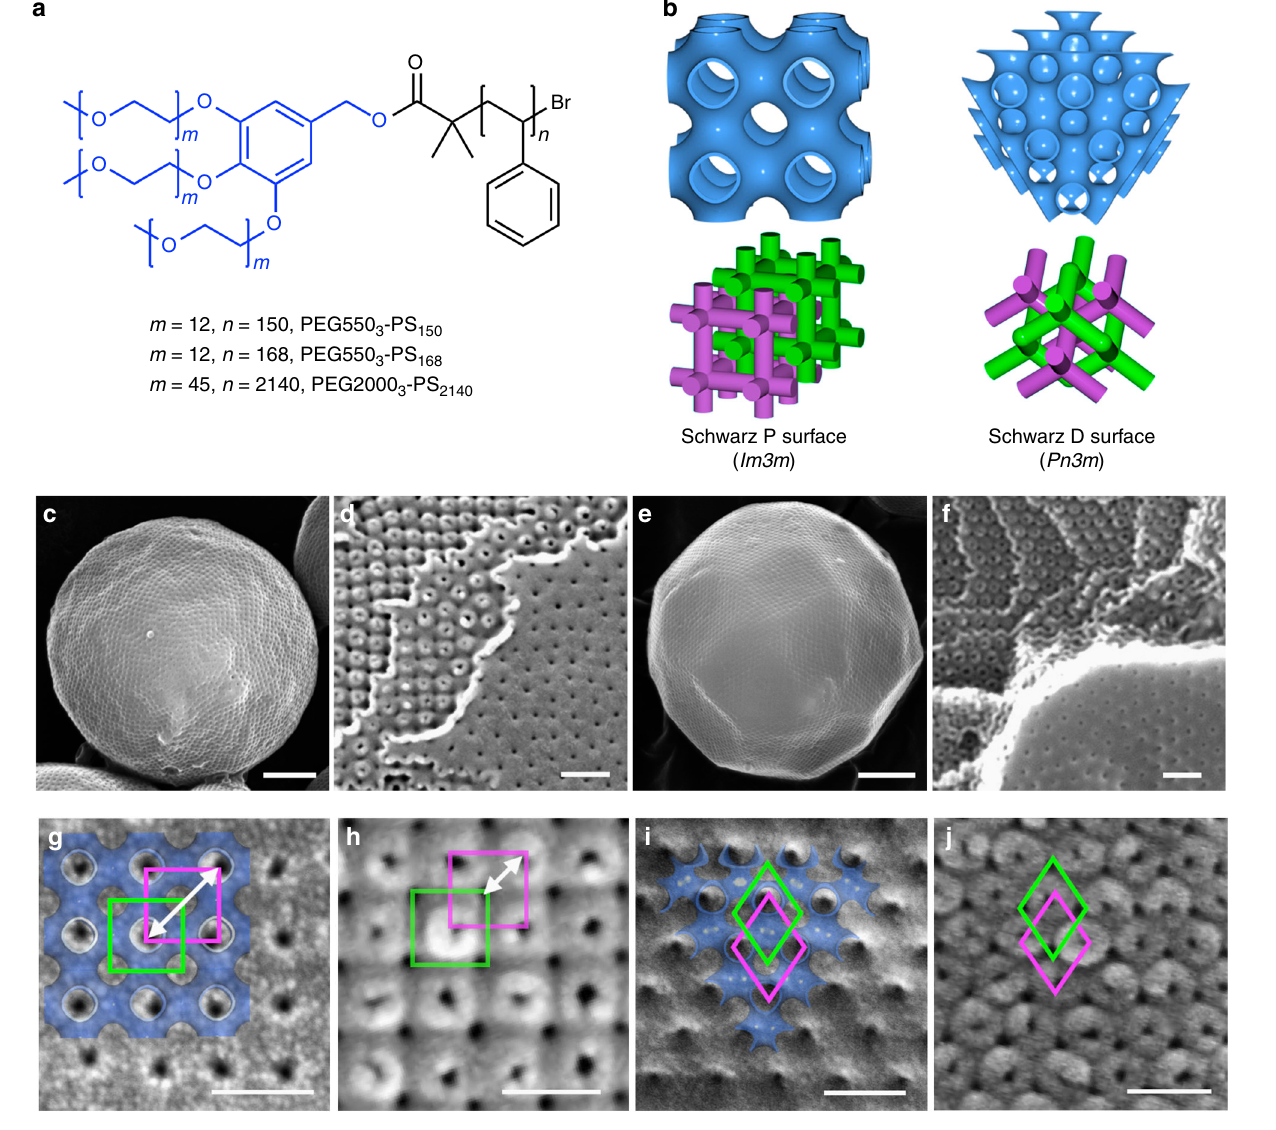
Fig. 1 Interfacial topology of polymer cubosomes (PCs). a Chemical structure of the BCP used in this study. b Two representative lattices of the internal cubic mesophases of BCP bilayers. Color-coded skeletal networks represent two non-intersecting channel networks embedded in the BCP cubic mesophases. c , e SEM images showing the spherical morphology of the PCs of PEG550 3 -PS 150 ( c ) and PEG550 3 -PS 168 ( e ). Scale bars are 1 μ m. d , f SEM images of fractured PCs of PEG550 3 -PS 150 ( d ) and PEG550 3 -PS 168 ( f ) showing the interface and internal cubic mesophase of the BCP bilayers. Scale bars are 200 nm. g – j SEM images showing the surface topology of the PC of PEG550 3 -PS 150 ( Im (cid:1) 3 m space group) ( g ) and PEG550 3 -PS 168 ( Pn (cid:1) 3 m space group) ( i ). The superimposed images are computer-generated (100) plane of the Schwarz P surface ( g ) and (111) plane of the Schwarz D surface ( i ). SEM images of the internal Schwarz P ( h ) and D ( j ) surfaces of the corresponding PCs indicate the interfacial capping of one of two internal channel networks. Scale bars are 100